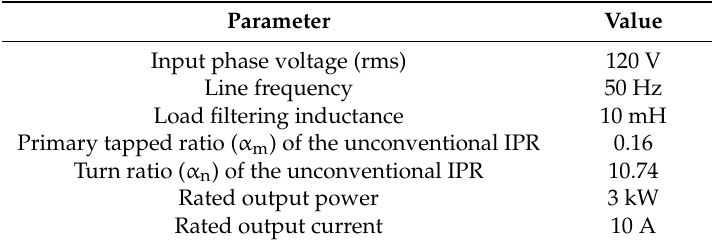
Table 1. Rectifier specifications and components for